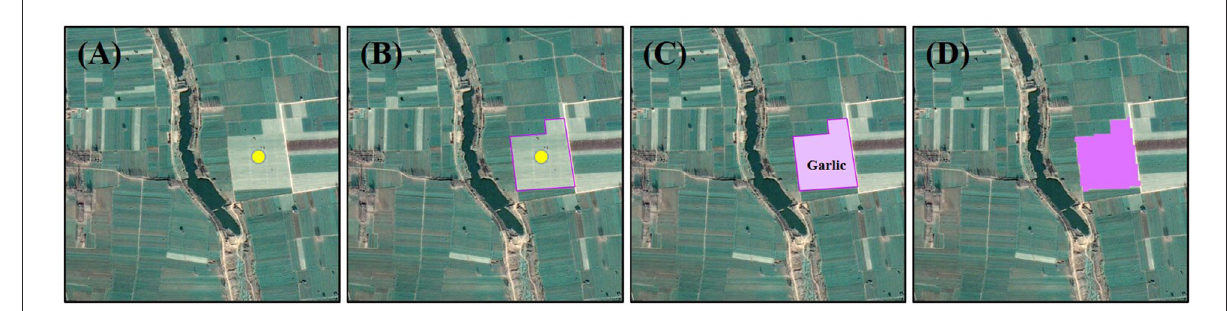
FIGURE12 Flow diagram for validation data production. (A) The Google Earth image. (B) The results of vectorization, where the purple line is the garlic cropland boundary. (C) The results for identifying the attributes of the vector polygon. (D) The raster converted from the vector polygon.